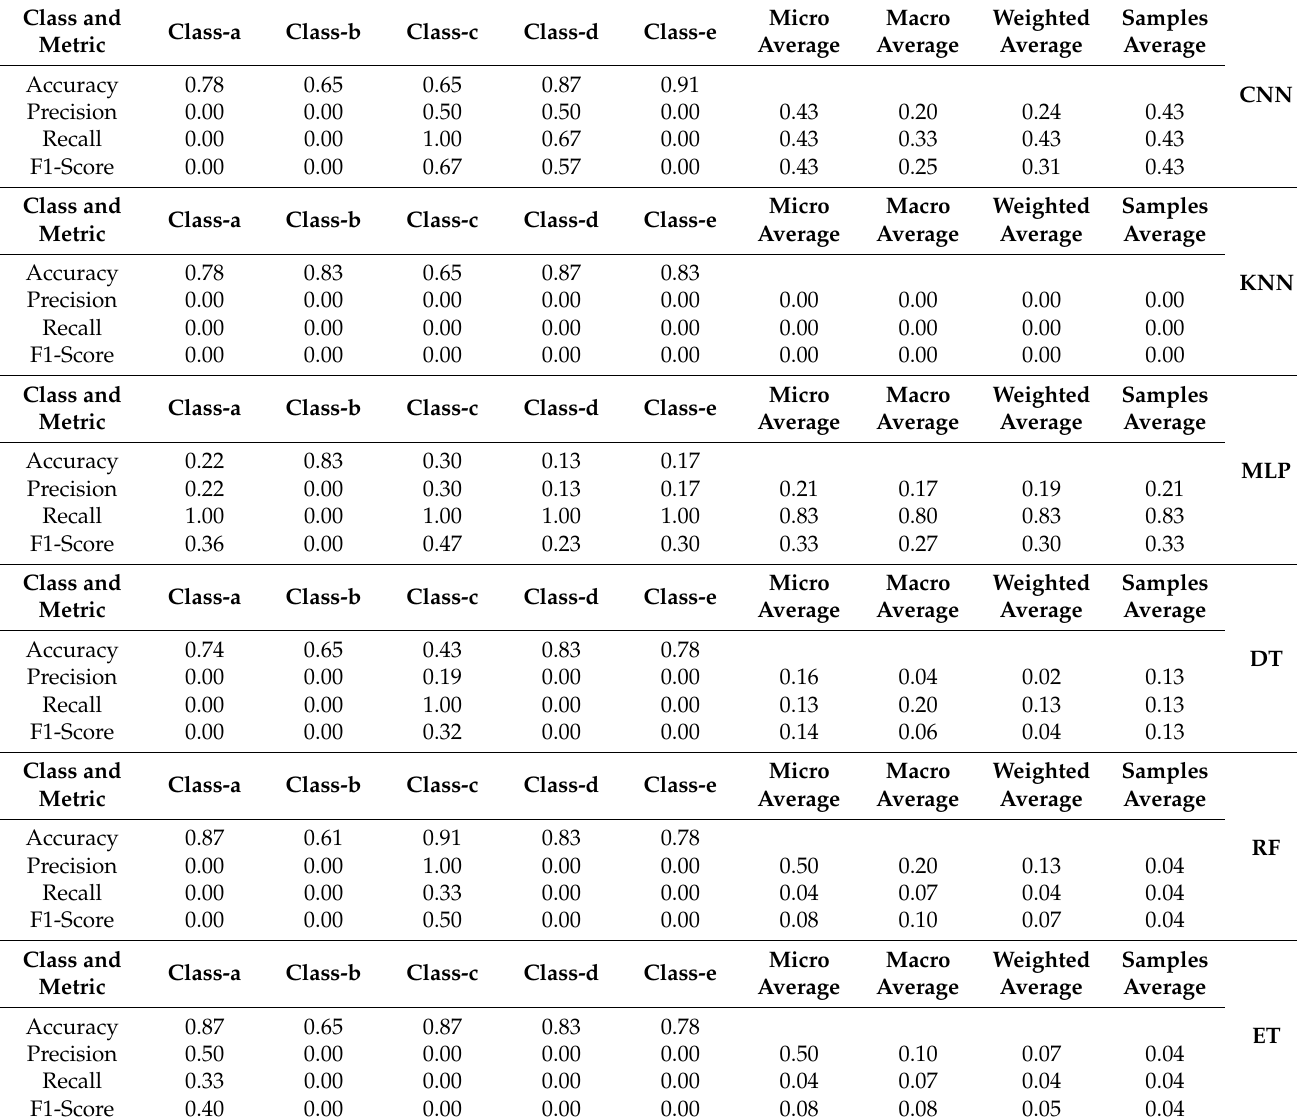
Table 6. Evaluation metrics for the CNN, KNN, MLP, DT, RF, and ET classifiers on the phase-only image dataset.